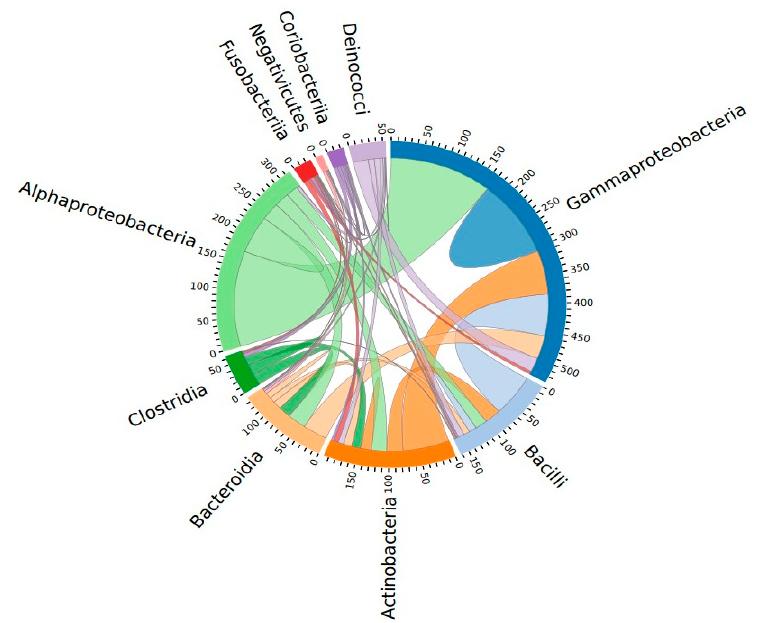
Figure 7. The chord diagram displays the network of 10 candidates that co-occur in a pairwise se- quence. Each sector of the circle represents a node (i.e., taxon) in the network, and its width reflects the sum of the co-occurrences between each